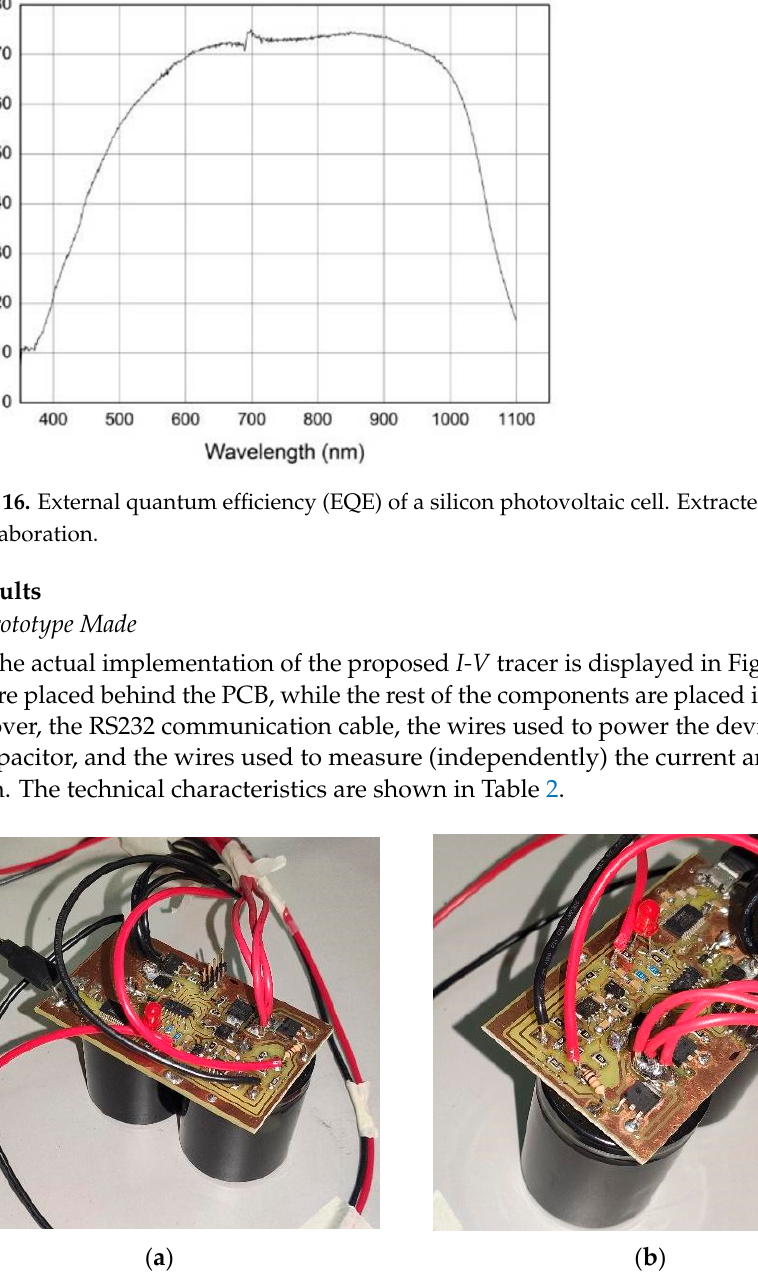
Figure 17. Prototype implementation of the proposed device. Table 2. Technical characteristics of the device produced.